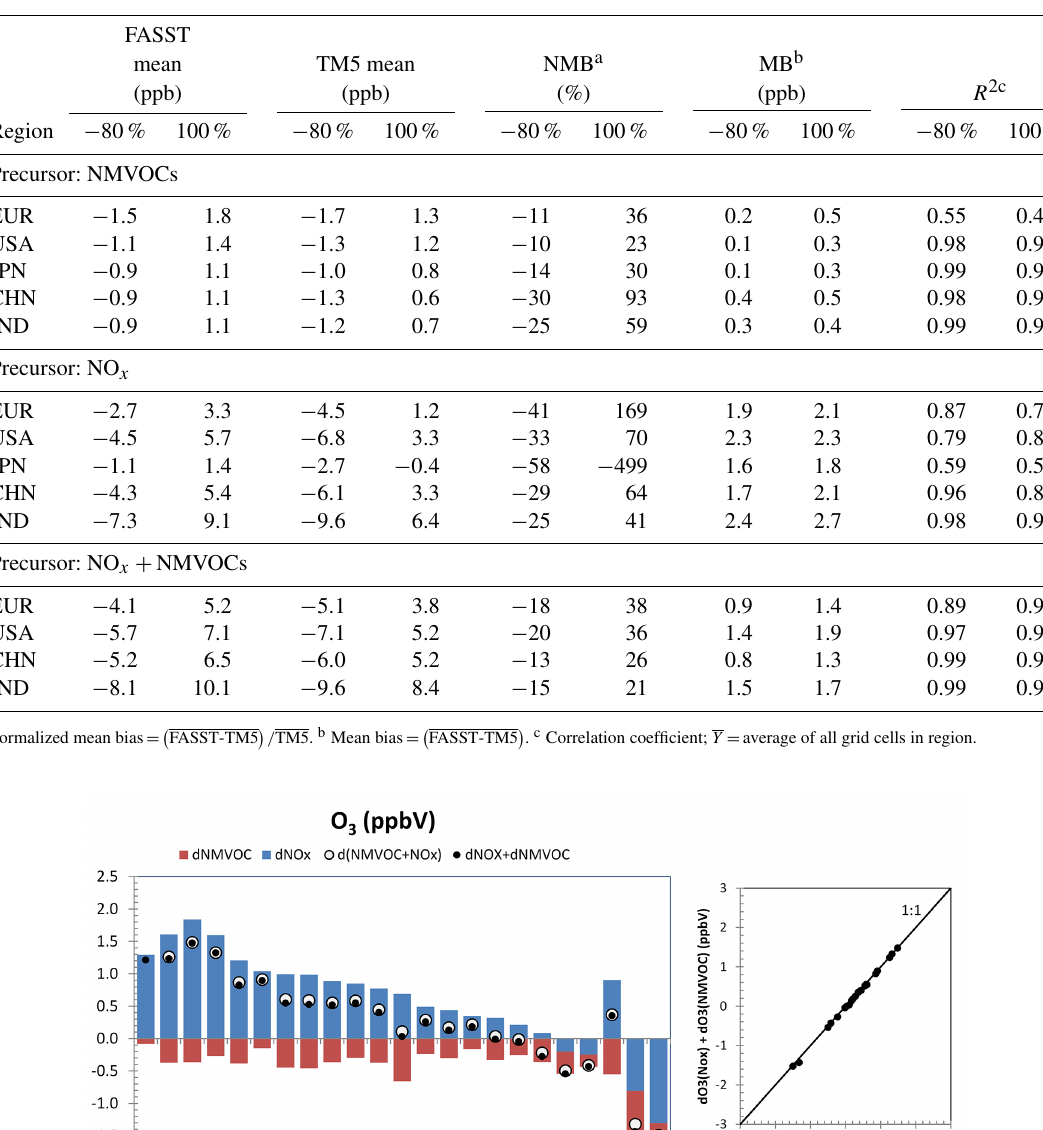
Table 5. Statistical metrics describing the correspondence between the linearized FASST- and TM5-computed change in O 3 exposure metric 6mDMA1 upon − 80% and 100% emission perturbation in its precursors (NMVOCs, NO x , and combined NO x + NMVOCs), relative to the RCP2000 base scenario. Statistics are calculated over all 1 ◦ × 1 ◦ grid cells in each region. Statistics for total concentrations are given in Sect. S7.